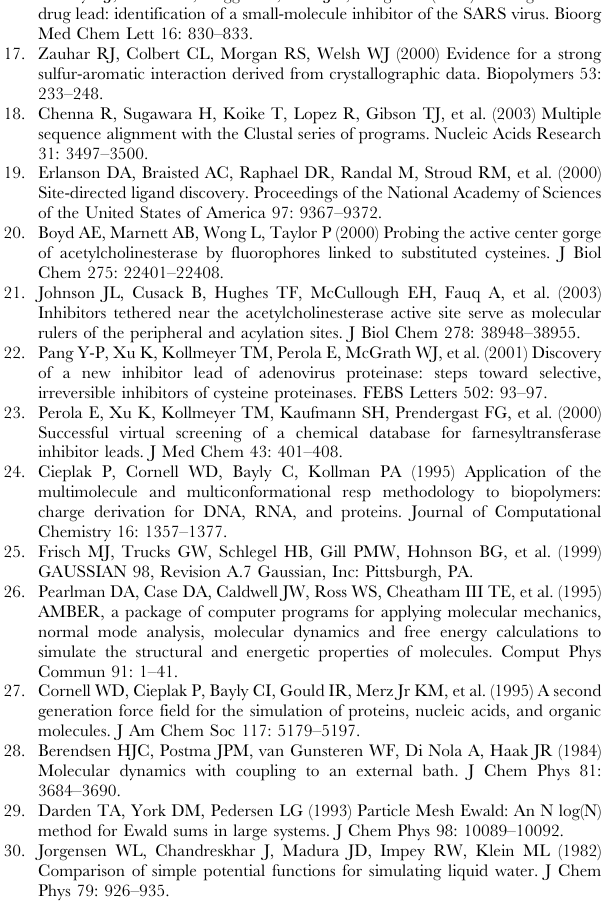
by CLUSTAL W (1.83). C286 and R339 of Anopheles gambiae acetylcholinesterase and the corresponding residues in other species are colored in red.